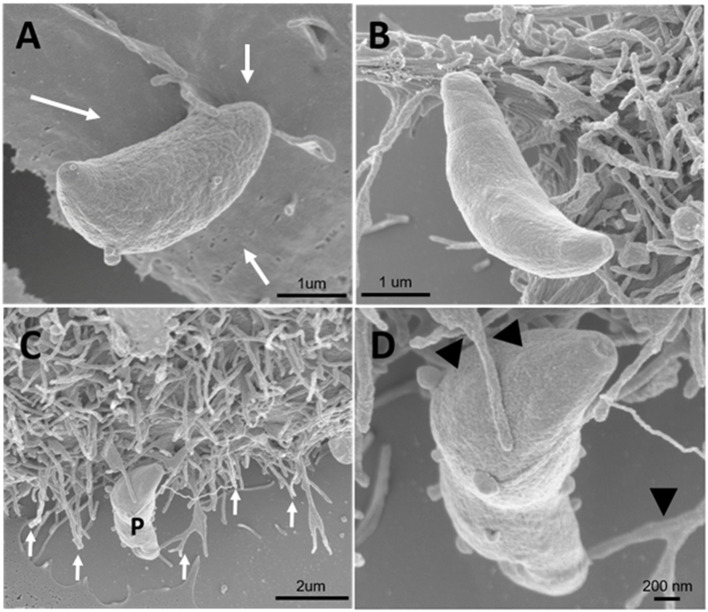
Field emission scanning electron microscopy of the HFF1 cells treated with amiloride or sucrose hypertonic medium, washed with PBS (three times) and allowed to interact with tachyzoites. (A–D) After 30 min of interaction with the cells the parasites attached to the membrane of the host cells (white arrows). (B–D) After 30 min of parasite interaction with the cells that were previously treated with hypertonic medium of sucrose, a large amount of membrane projections was observed around the parasite attached to the cell (arrows and arrowheads).